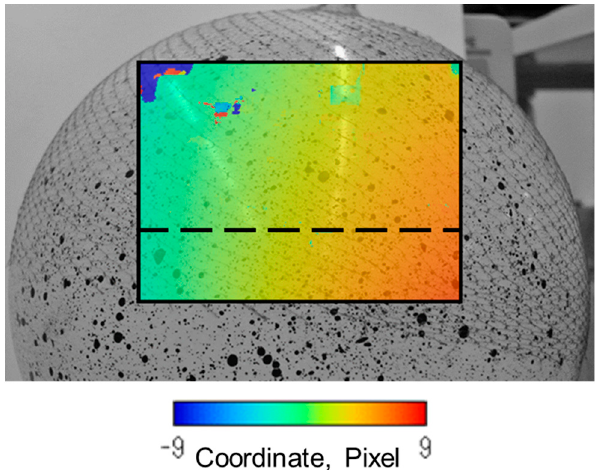
(7) Figure 5. X-direction deformation and deviation between the distribution map for the region of interest theoretical and experimentally measured values of strain. 3.3. Comparison of DIC and SiDIC Measurements Accuracy Next, the measurement accuracy of SiDIC was verified by using balloon (b) in Figure 3. Figure 6 shows the displacement distribution in the x-direction obtained from DIC. We analyzed the deformation at the dotted line control path using SiDIC and compared the corresponding results of